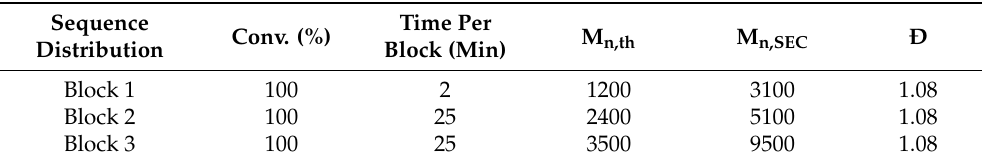
Table 2. Summary of characteristics of triblock copolymers of DMA, NIPAM and HEAA by